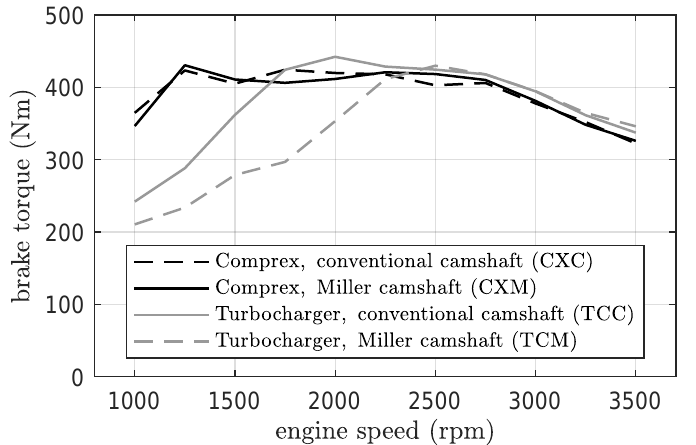
Figure 7. Full-load brake torque results with different charging systems and different